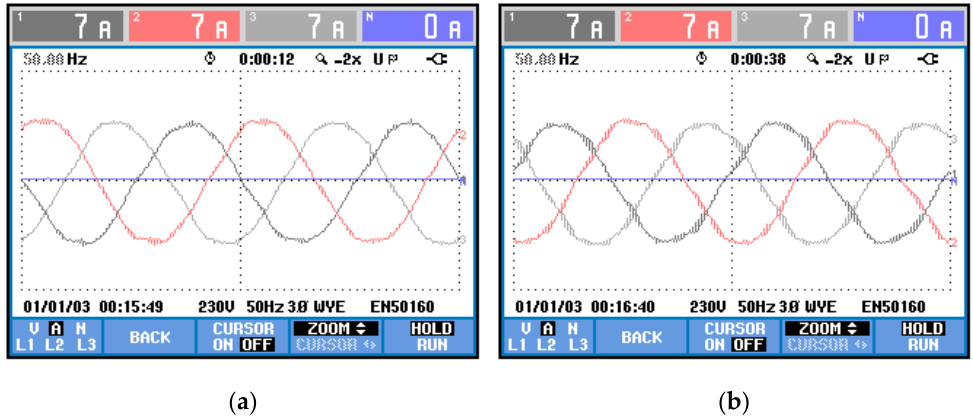
Figure 4. Phase currents wave shape: ( a ) proposed method; ( b ) state-of-the-art alternative.